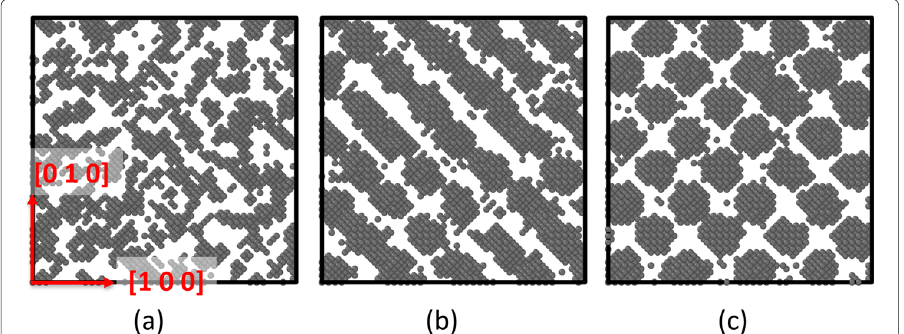
Fig. 4 (Color online) 3-stage formation process of a void superlattice from AKMC simulations in bcc Mo. The doses level is 0.8, 5.2 and 8.2 dpa in ( a ), ( b ) and ( c ). The simulation cell size is 40 × 40 × 40 a 3